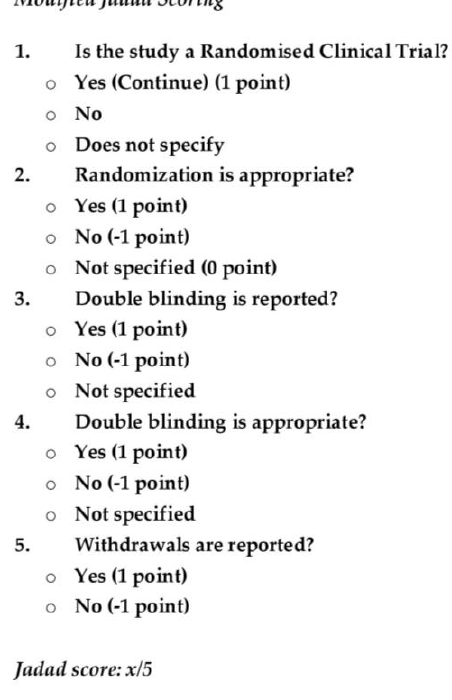
Figure 2. Modified Jadad questionnaire. Table 1. List of articles reviewed in this study and the study characteristics.